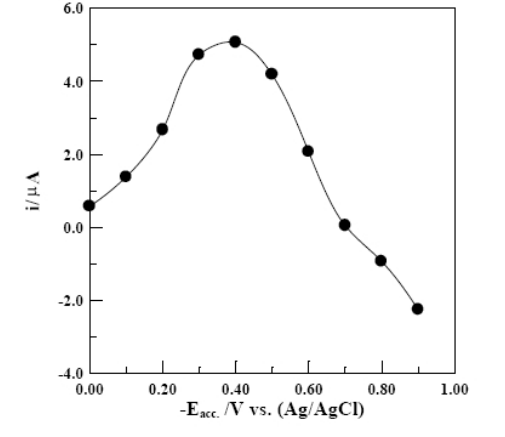
Fig. 4 Effect of accumulation potential ( E acc ) on the SW-AdCS voltammetric peak cur- rent ( i p ) for 2 × 10 − 7 M bulk tolmetin in percholric acid of pH 2 after adsorptive accu- mulation onto the HMDE for 30 s ( f = 120 Hz, Δ s = 12 mV and E sw = 50 mV).